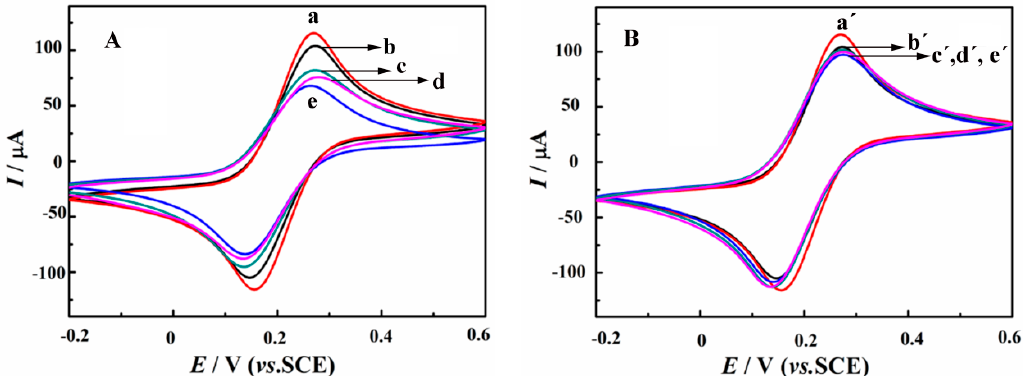
Figure 4. ( A ) Cyclic voltammograms of an AuNPs / GCE ( a ), a bare GCE ( b ), a MIP-poly[(Cys)VIMBF 4 ] / AuNPs / GCE before ( e ) and after ( c ) removing AFP, and rebinding AFP ( d ); ( B ) Cyclic voltammograms of an AuNPs / GCE ( a ´), a bare GCE ( b ´), a NIP-poly[(Cys)VIMBF 4 ] / AuNPs / GCE before ( e ´) and after ( c ´) removing AFP, and rebinding AFP ( d ´); AFP used for incubation is at the concentration of 20.0 ng mL − 1 ; Scan rate: 0.1 V s − 1